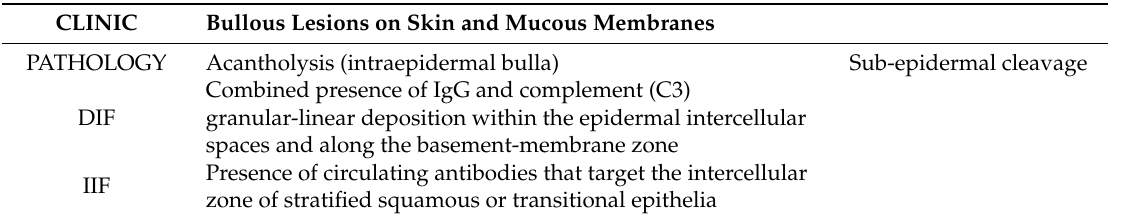
Table 2. Resume of PNP diagnostic